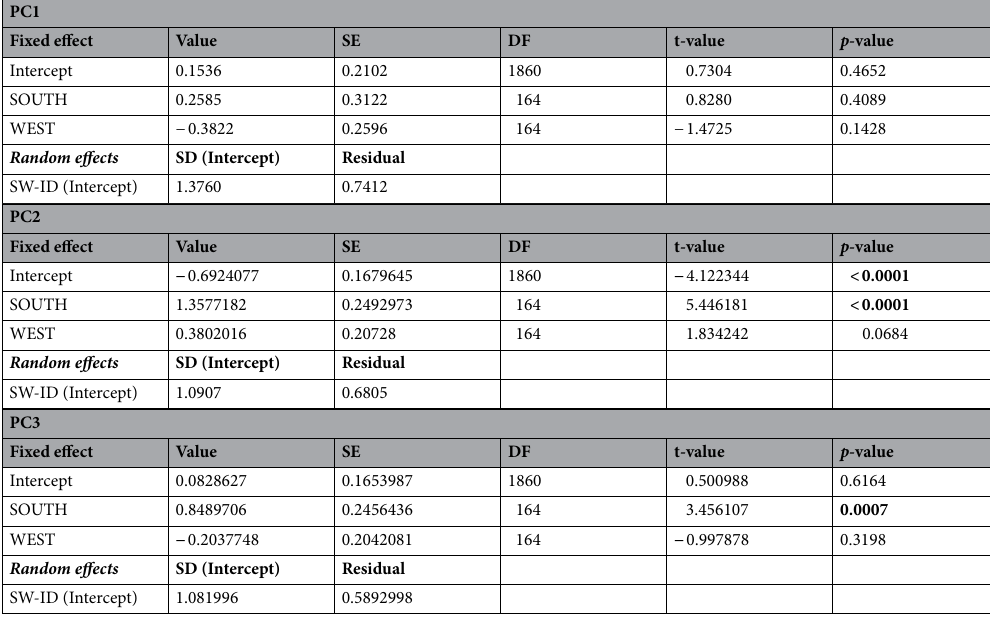
Table 1. Generalized linear mixed-effect model (GLMM) with ‘region’ as explanatory variable on PC1, PC2 and PC3. The upper section shows the significant effects of the assessed explanatory variables. Value, standard errors (SE), t-values, and significance level ( p -value) for variables retained in the model are provided for fixed effects (explanatory variables), while estimates of the standard deviations (SD) are reported for random effects (SW-ID). Significant level in bold.